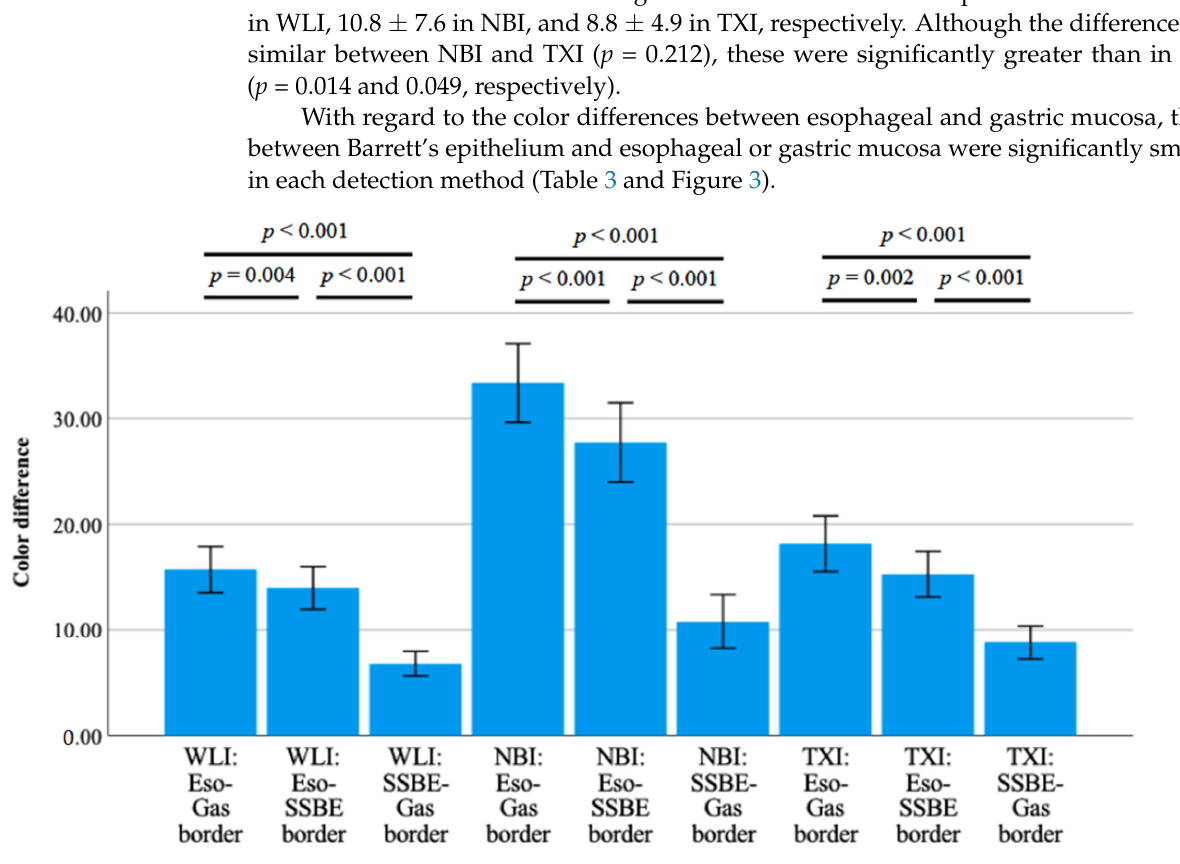
Figure 3. Color differences among short-segment Barrett’s esophagus, esophageal, and gastric mucosa with three kinds of detection methods using third-generation high-vision GIF-1200N. Color differences between SSBE and esophageal or gastric mucosa in all detection methods were significantly smaller ( p < 0.001 and < 0.001). Abbreviations: NBI: narrow-band imaging, SSBE: short-segment Barrett’s esophagus, TXI: texture and color enhancement imaging, WLI: white-light imaging. The mean ± SD of the visibility scores of Barrett’s esophagus detection evaluated by six endoscopists were significantly higher for TXI (3.4 ± 0.4) than for WLI (2.9 ± 0.8, p = 0.016) and NBI (3.0 ± 0.4, p = 0.022) (Table 4). The visibility scores between gastric mucosa and Barrett’s esophagus were significantly higher for TXI (2.6 ± 0.5) than for NBI (2.2 ± 0.2, p = 0.002). Table 4. Visibility assessment of Barrett’s esophagus. WLI